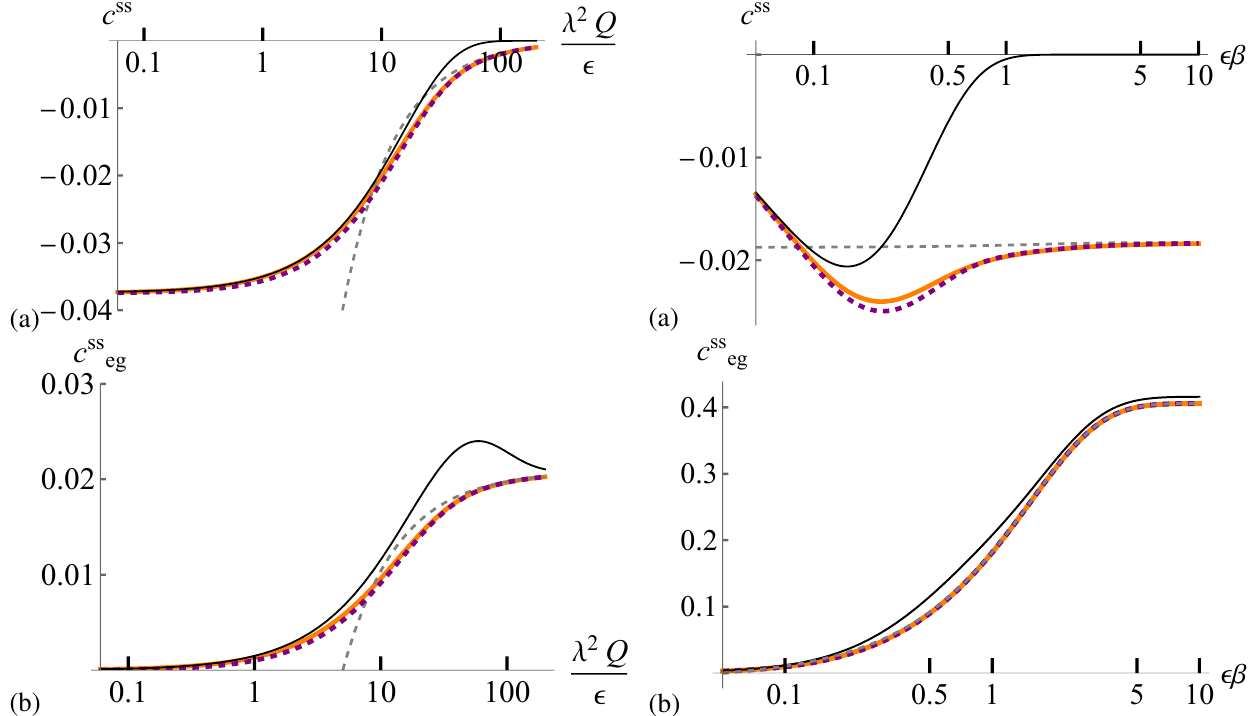
Figure 1: Plots in the semi-log scale of the mean force Gibbs Figure 2: Plots in the semi-log scale of the mean force Gibbs |−⟩ in the eigenbasis of A, |−⟩ in the eigenbasis of A, and state coherences (a) c ss : = ⟨ + | ρ ss state coherences (a) c ss : = ⟨ + | ρ ss S S | g ⟩ in the eigenbasis of H | g ⟩ in the eigenbasis of H and (b) c ss : = ⟨ e | ρ ss (b) c ss : = ⟨ e | ρ ss S , in function of S , in function of the e ,g e ,g S S the coupling strength λ 2 Q in unit of ϵ , for ∆ = 1 . 5 ϵ , ω c = 2 ϵ inverse temperature ϵβ , for ∆ = 1 . 5 ϵ , ω c = 1 ϵ and λ 2 Q = 10 ϵ . and ϵβ = 0 . 1 . The orange thick solid curve corresponds to The orange thick solid curve corresponds to (31) using the high (31) using the high temperature approximation (33) of f + , − ( β ) , temperature approximation (33) of f + , − ( β ) , while the gray thin while the gray thin dashed line corresponds to the further dashed line (almost indistinguishable from the orange curve) simplified expression (34) of f + , − ( β ) . The purple thick dashed corresponds to the further simplified expression (34) of f + , − ( β ) . line is the mean force Gibbs state coherences given by the high The purple thick dashed line is the mean force Gibbs state temperature expression derived in [44]. The black thin line is coherences given by the high temperature expression derived the mean force Gibbs state coherences given by (40) . in [44]. The black thin line is the mean force Gibbs state coherences given by (40)